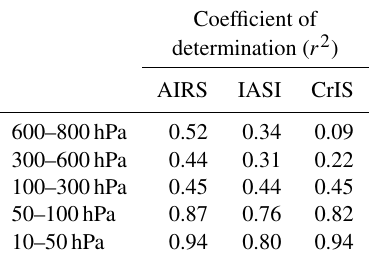
Table 2. Coefficient of determination ( r 2 ) of ozone retrievals by three IR satellite sensors (AIRS, IASI, and CrIS) in five broad layers with respect to ozonesonde observations.